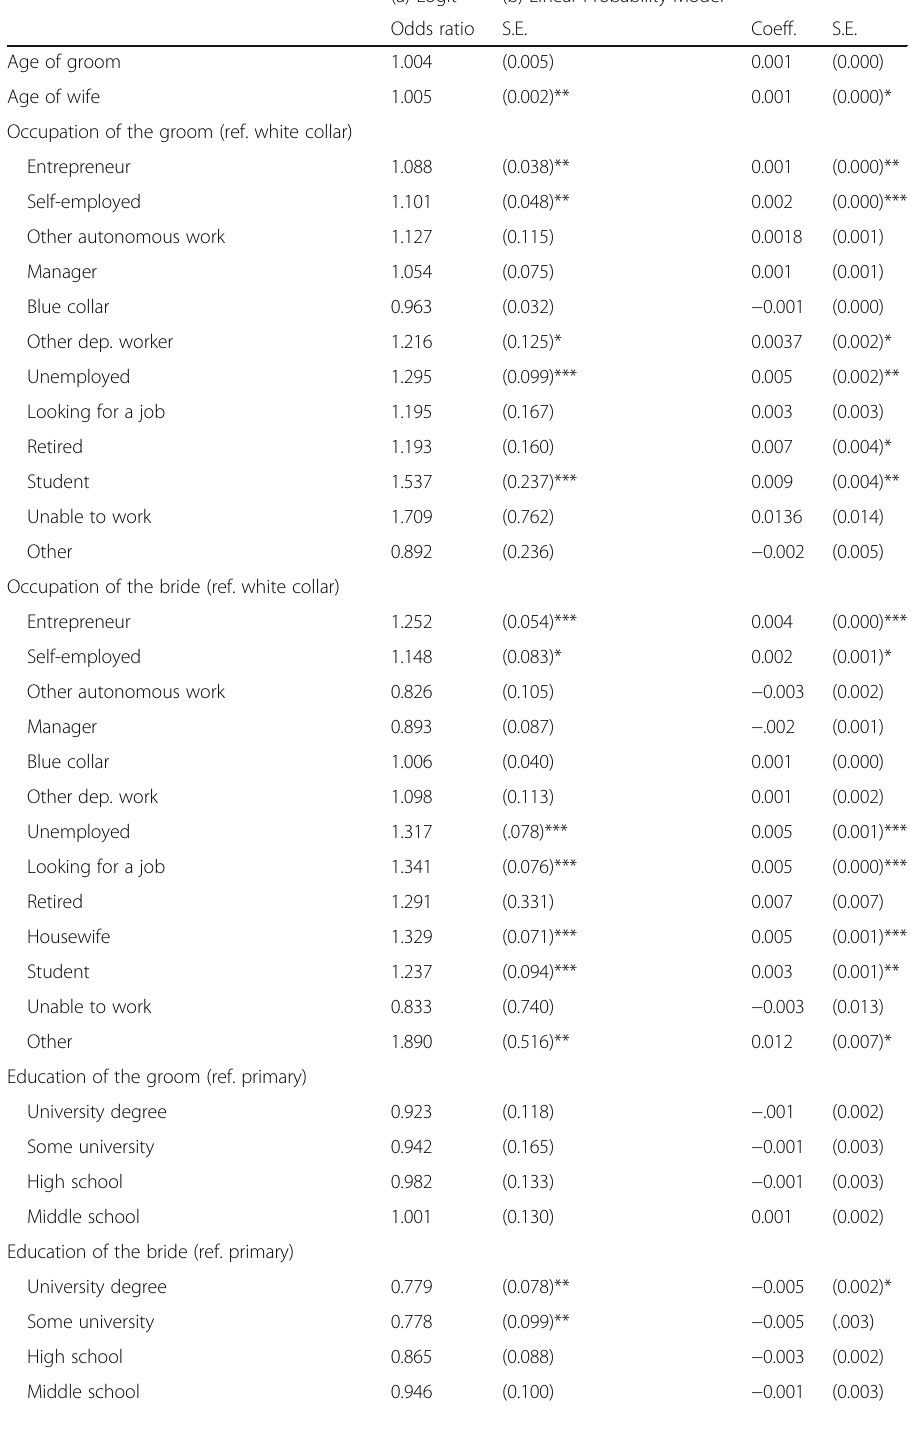
Table 5 Socio-demographic characteristics associated with the choice of marrying during the Lenten period: results from a multivariate logistic regression. Italy, 2007 –